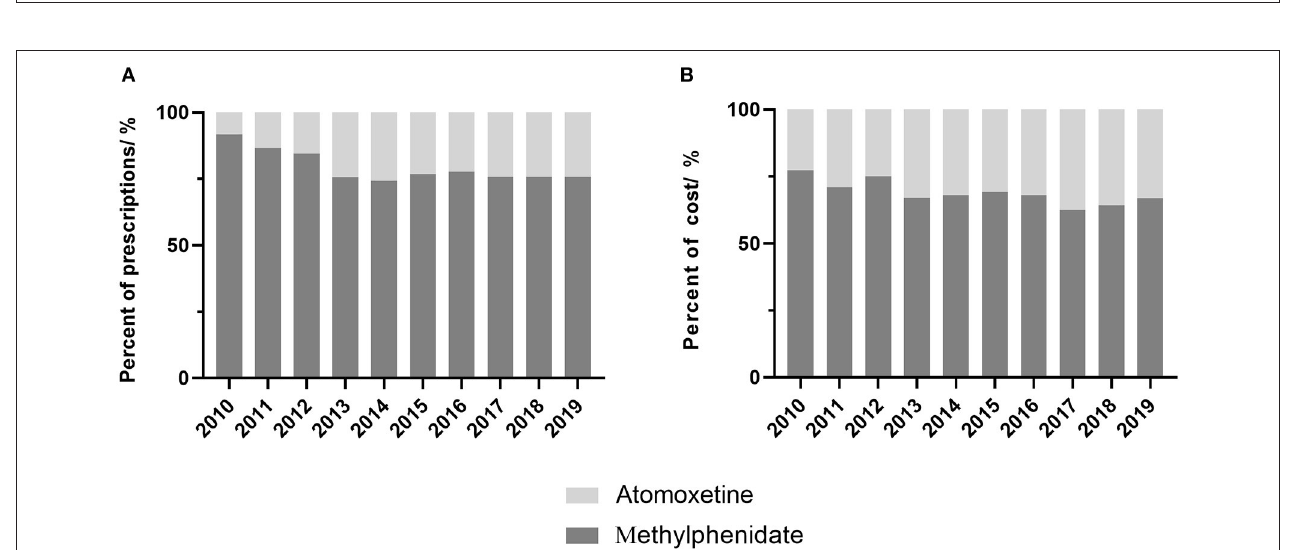
FIGURE 2 | Proportion of prescriptions and cost of ADHD drugs by year. (A) proportion of prescriptions, (B) proportion of